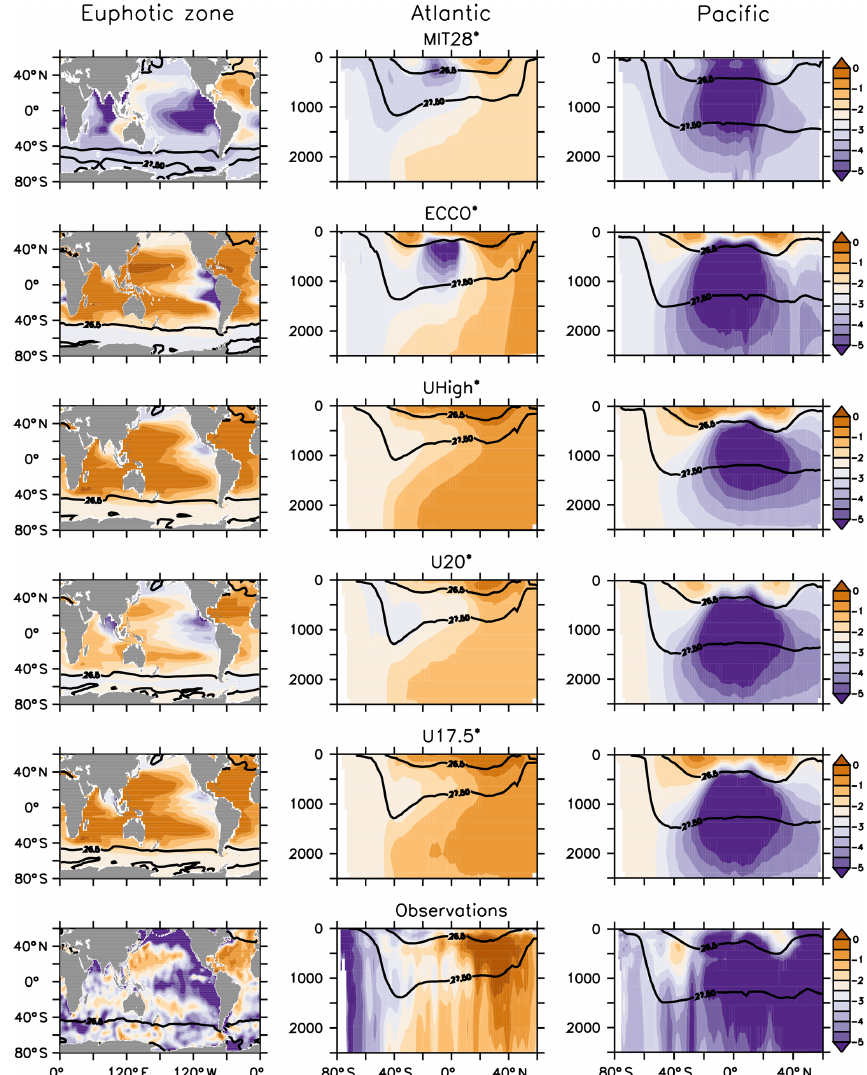
Figure 5. Excess nitrate N ∗ (N ∗ = NO 3 − 16 × PO 4 ) of optimal model configurations, averaged over the euphotic zone (left panels) and of zonal mean nitrate and phosphate in the Atlantic and Pacific (middle panels and right panels, respectively). Lines denote density of σ θ = 27 and σ θ = 27 .